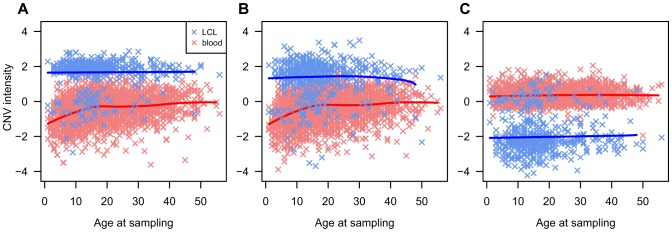
Spurious associations at TCR and IGH loci.Age at sampling (x-axis) versus CNV intensity signal (y-axis) for the three most associated Immunoglobin Heavy (IGH) and T cell receptor (TCR) loci CNVs. Each point represents an individual in the study (irrespective of familial/T1D status). Blue crosses indicate DNA extracted from LCLs (N = 551) and red crosses DNA extracted from blood (N = 2,981). Red and blue lines have been fitted to the LCL/blood data using cubic splines. A - CNVR6085.1 (chr14:21977832-21987926) mapping to TCR alpha and TCR delta locus on chr14, FBAT-CNV P = 3.6 10−63. The plot shows correlation between age at sampling and probe intensity for DNA extracted from blood samples. B - CNVR3590.1 (chr7:142194021-142204412) mapping to TCR beta locus on chr7, FBAT-CNV P = 4.4 10−31. The plot shows correlation between age at sampling and probe intensity for DNA extracted from blood samples. C - CNVR6294.22 (chr14:105433837-105441555) mapping to Ig heavy chain locus on chr14, FBAT-CNV P = 6.5 10−5. No age-dependent effect was detected at this locus.